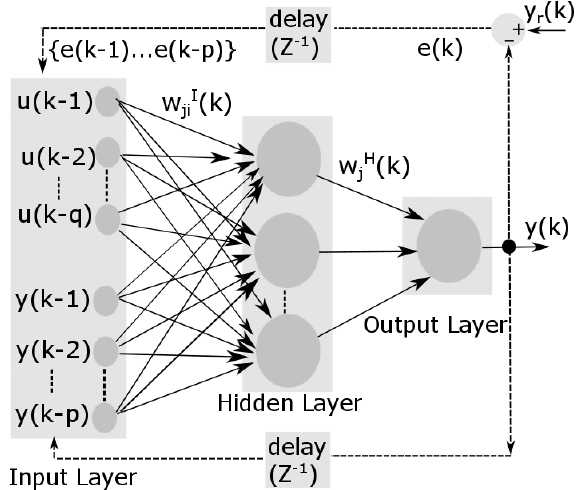
Fig. 4. Structure of the neural NARMAX